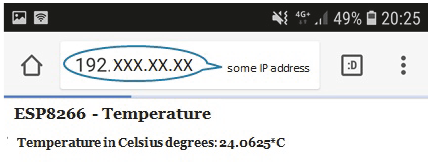
Figure 9: A measured temperature is periodically published on the designated web page in real time.